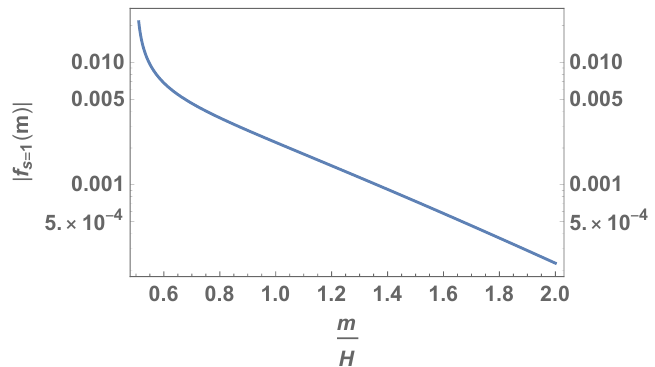
Figure 6 . Strength of NG mediated by spin-1 KK gauge bosons for in(cid:13)aton-KK mixing (cid:26) = 0 : 3 and derivative of KK wavefunction on the in(cid:13)ationary boundary # 0 (0) = 1. Such strengths for the range of masses shown are observable within cosmic variance (see section